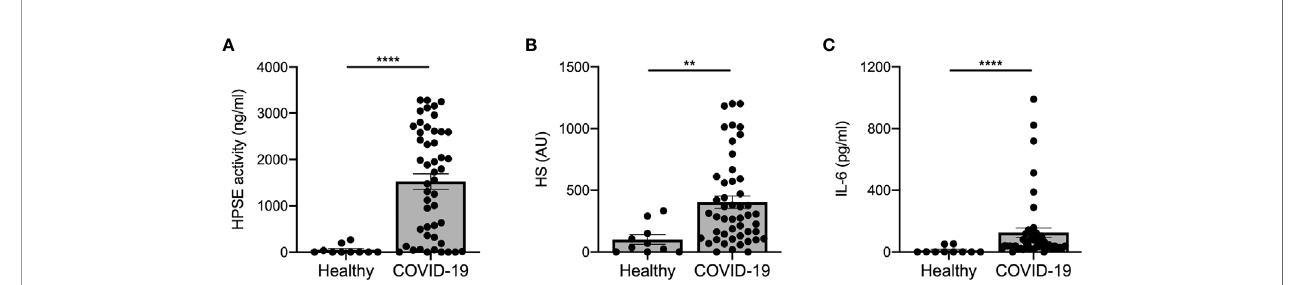
FIGURE 1 | COVID-19 patients display increased HPSE activity, and elevated levels of heparan sulfate and IL-6 in plasma. (A) HPSE activity was increased in plasma of COVID-19 patients compared to healthy controls. HPSE activity was measured using an in-house developed ELISA with a speci fi c anti-HS antibody. (B) HS levels were increased in plasma of COVID-19 patients compared to healthy controls. HS levels were measured by an in-house developed competition ELISA using a speci fi c anti-HS antibody. (C) IL-6 levels were increased in plasma of COVID-19 patients compared to healthy controls. IL-6 levels were measured using a commercial IL-6 ELISA. Data were presented as mean ± SEM and tested for normal distribution with D ’ Agostino & Pearson omnibus normality test and statistical differences were calculated using Mann Whitney test (n = 10 healthy; n = 48 COVID-19; **p < 0.01; ****p < 0.0001). HPSE, heparanase; HS, heparan sulfate; Healthy, healthy controls; COVID-19, coronavirus disease-19 patients; AU, arbitrary units.